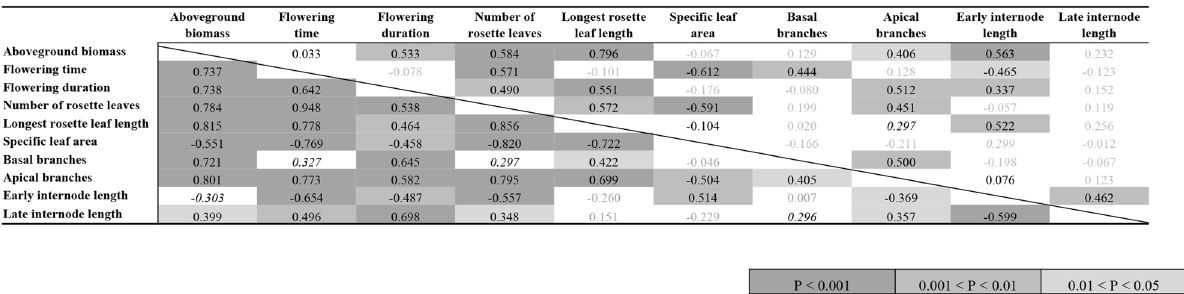
Table 3. Correlation matrix for traits in competition-absent (below diagonal) and competition-present (above diagonal) conditions. Significant terms ( P < 0.05) are shown in bold with increasingly darker shading indicating trait correlations with lower P values (in three categories: P < 0.001; 0.001 < P < 0.01; and 0.01 < P < 0.05); marginally significant correlations (0.05 < P < 0.10) are shown in